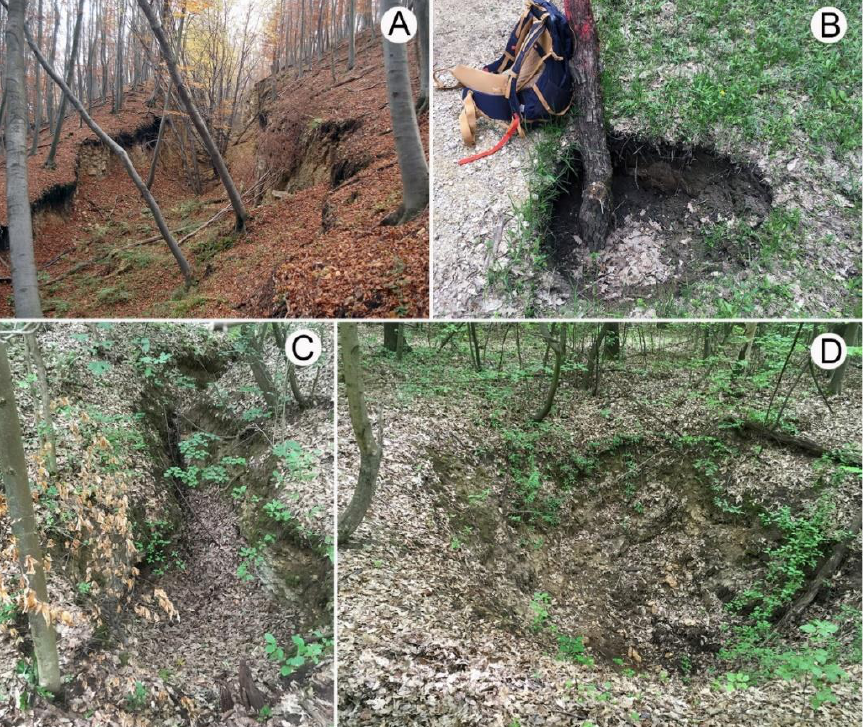
Figure 9. Pseudokarst features from Bocskor Hill: ( A ) graben feature (only partly areic) (Kopecskó); ( B ) circular pseudokarst dropout doline (own figure); ( C ) pseudokarst dropout doline of grike pattern (feature with collapse) (own figure); ( D ) circular pseudokarst suffosion doline (own figure) (the features developed on Middle Eocene limestone).